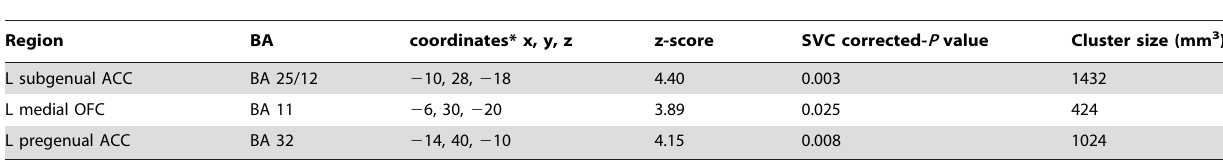
Table 1. Prefrontal regions with reduction in [ 11 C]FLB 457 BP following left DLPFC stimulation.